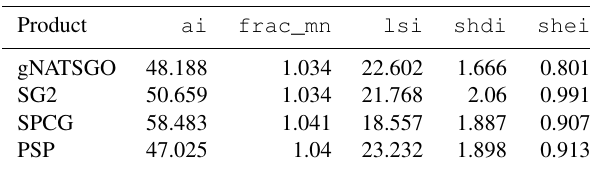
Table 4. Landscape metrics statistics for pH at 0–5cm. frac_mn is the mean fractal dimension, lsi is the landscape shape index, shdi is the Shannon diversity, shei is the Shannon evenness, and ai is the aggregation index.